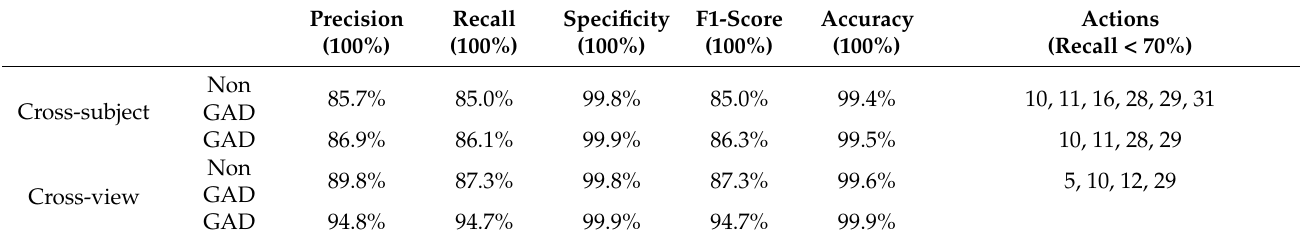
Table 7. The results of class score fusion with and without DAG transfer.